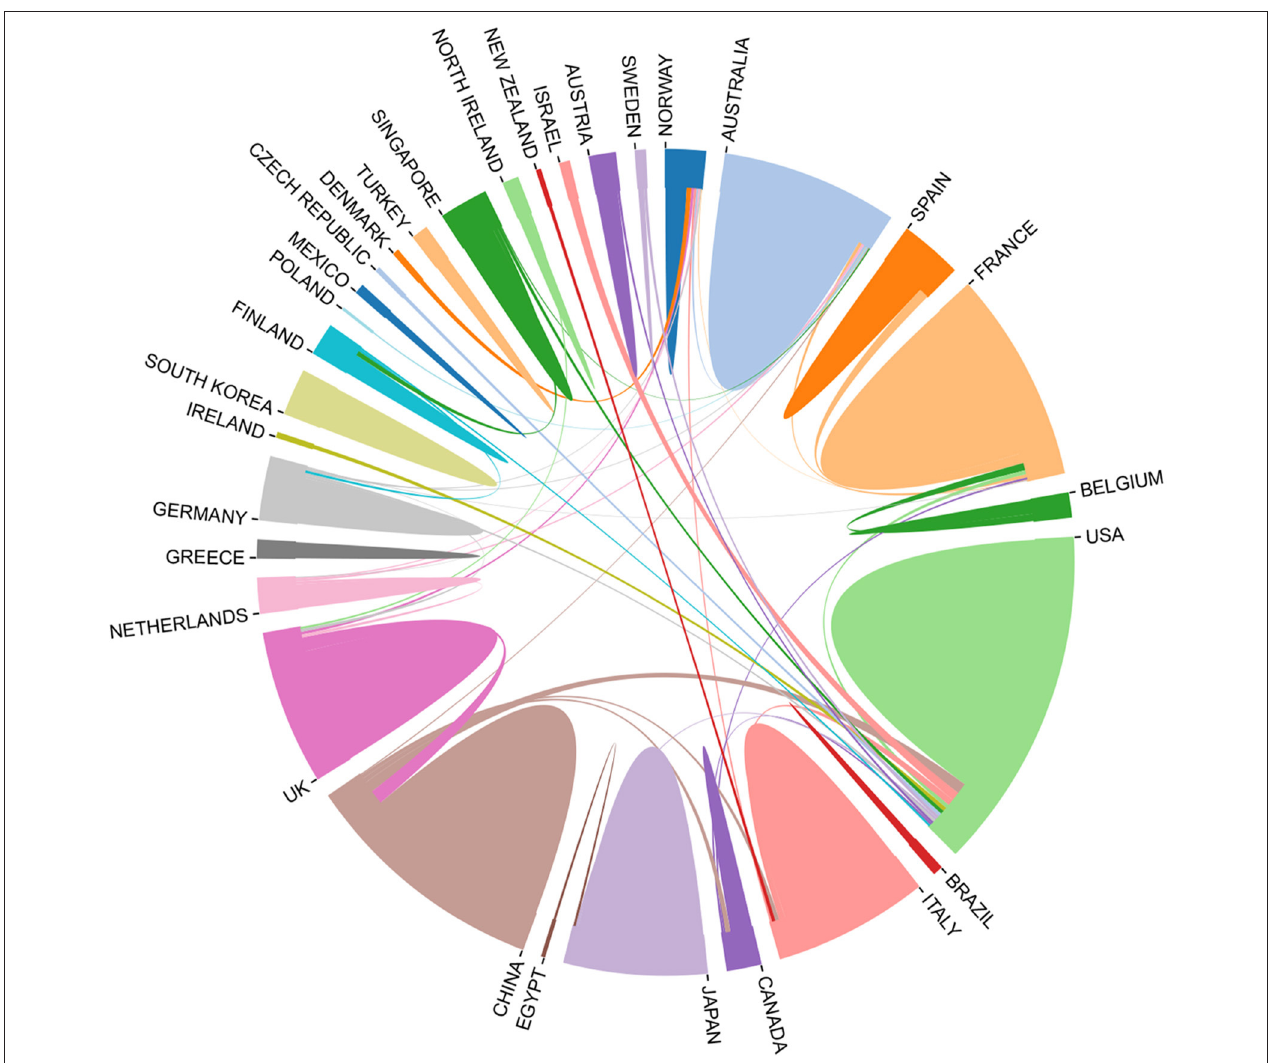
FIGURE 4 | The cooperation of countries in the field of music therapy for dementia from 2010 to